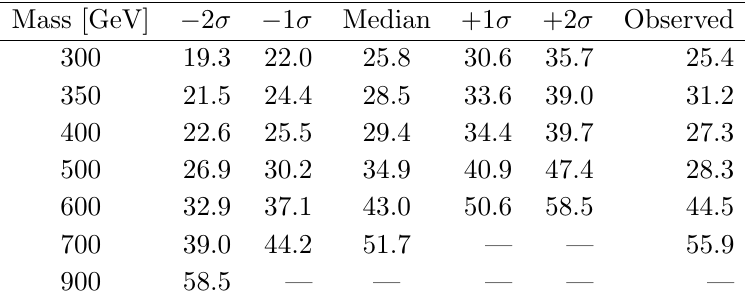
Table 2 . Expected and observed 95% CL upper limits on tan (cid:12) as a function of m A in the m mod+ (cid:22) = +200 GeV, benchmark scenario. Since theoretical predictions for tan (cid:12) > 60 are not reliable, entries for which tan (cid:12) would exceed this value are indicated by |.